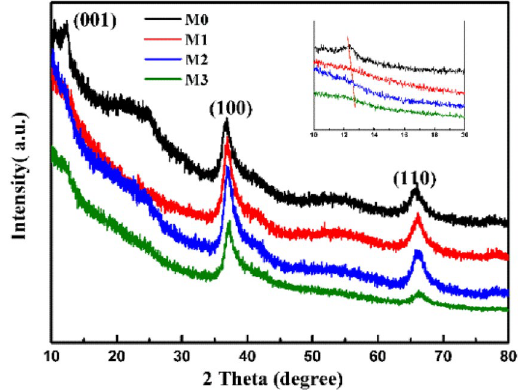
Figure 1. XRD patterns of the as-prepared manganese oxides.